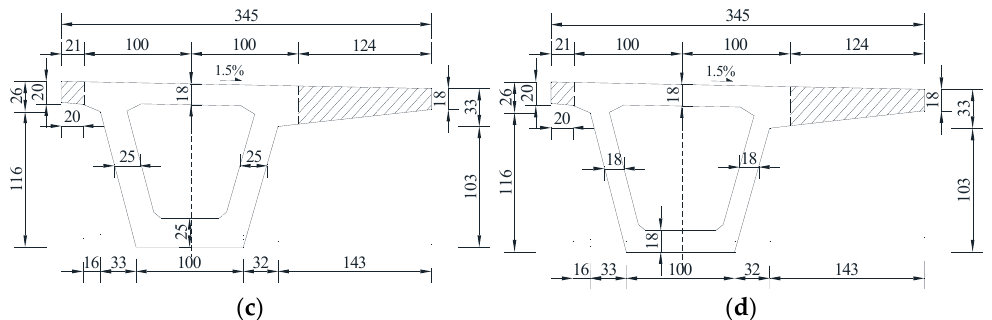
Figure 3. Cross-sectional diagrams of the box girders at the third and fourth spans (Unit: cm). ( a ) Front view; ( b ) Bottom view; ( c ) A-A section; ( d ) B-B section.